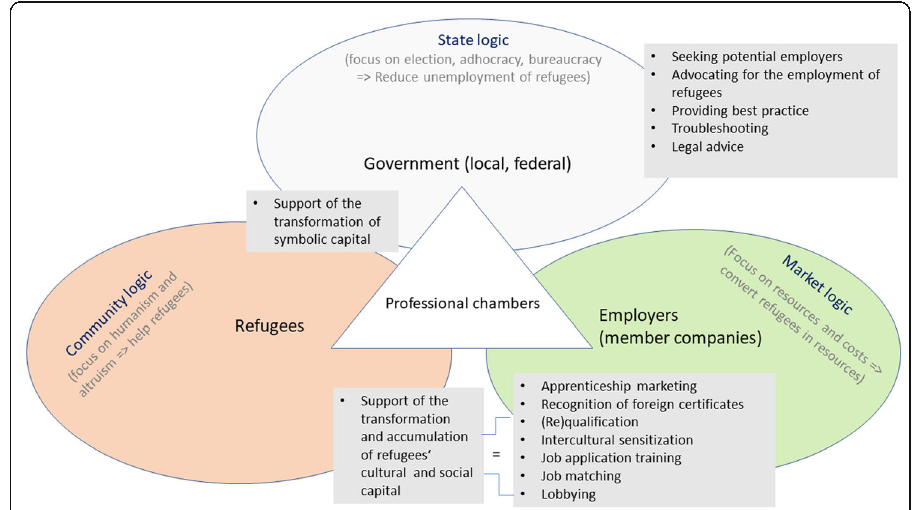
Fig. 2 Interrelatedness of institutional logics and chambers ’ labour market inclusion measures. Source: own